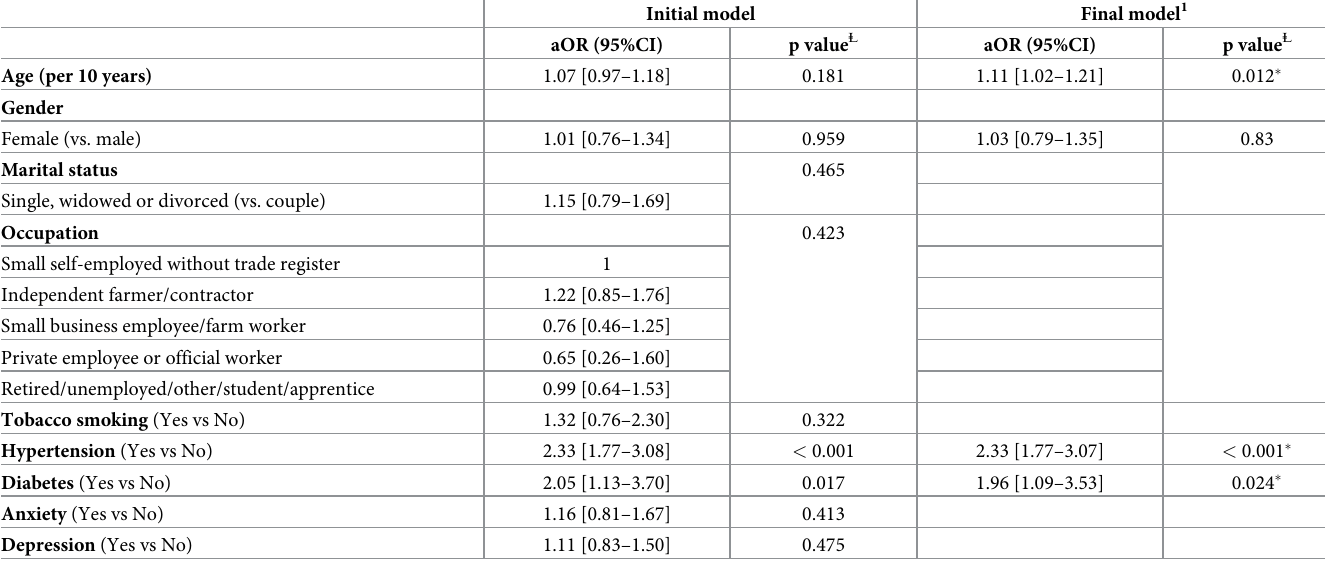
Table 3. Factors associated with systolic inter-arm blood pressure difference (sIABPD) � 10 mmHg , multivariable analysis, TAHES study, Benin